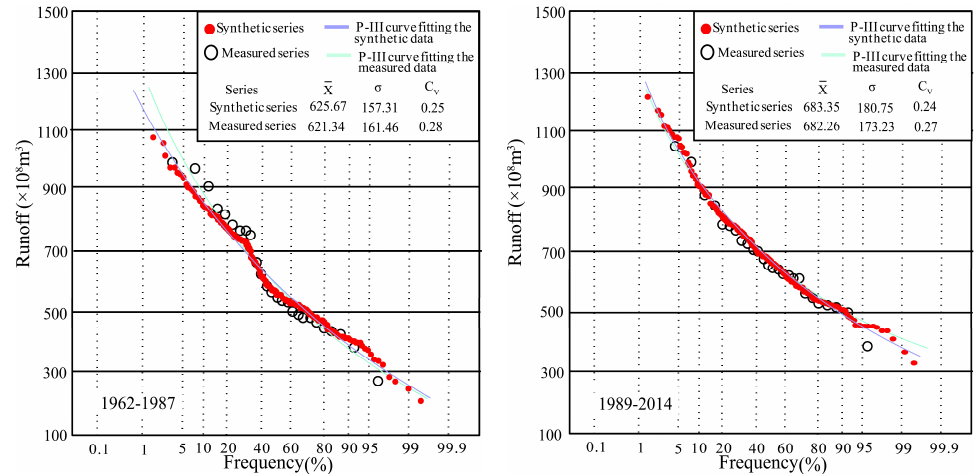
Figure 18. P-III frequency curves fitting segmented synthetic and measured runoff series and statistical parameters at Xiangtan gauge.